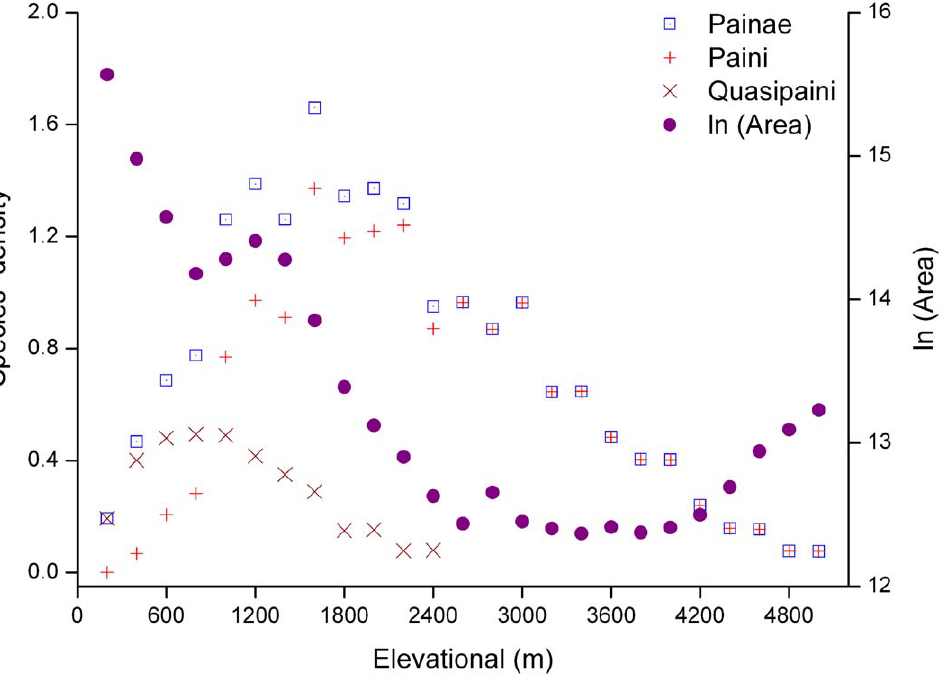
Figure 3. Changes in area and species density of spiny frogs along altitudinal gradient. Species density is the number of species per log- transformed and is shown for the subfamily Painae and the tribes Paini and Quasipaini respectively.